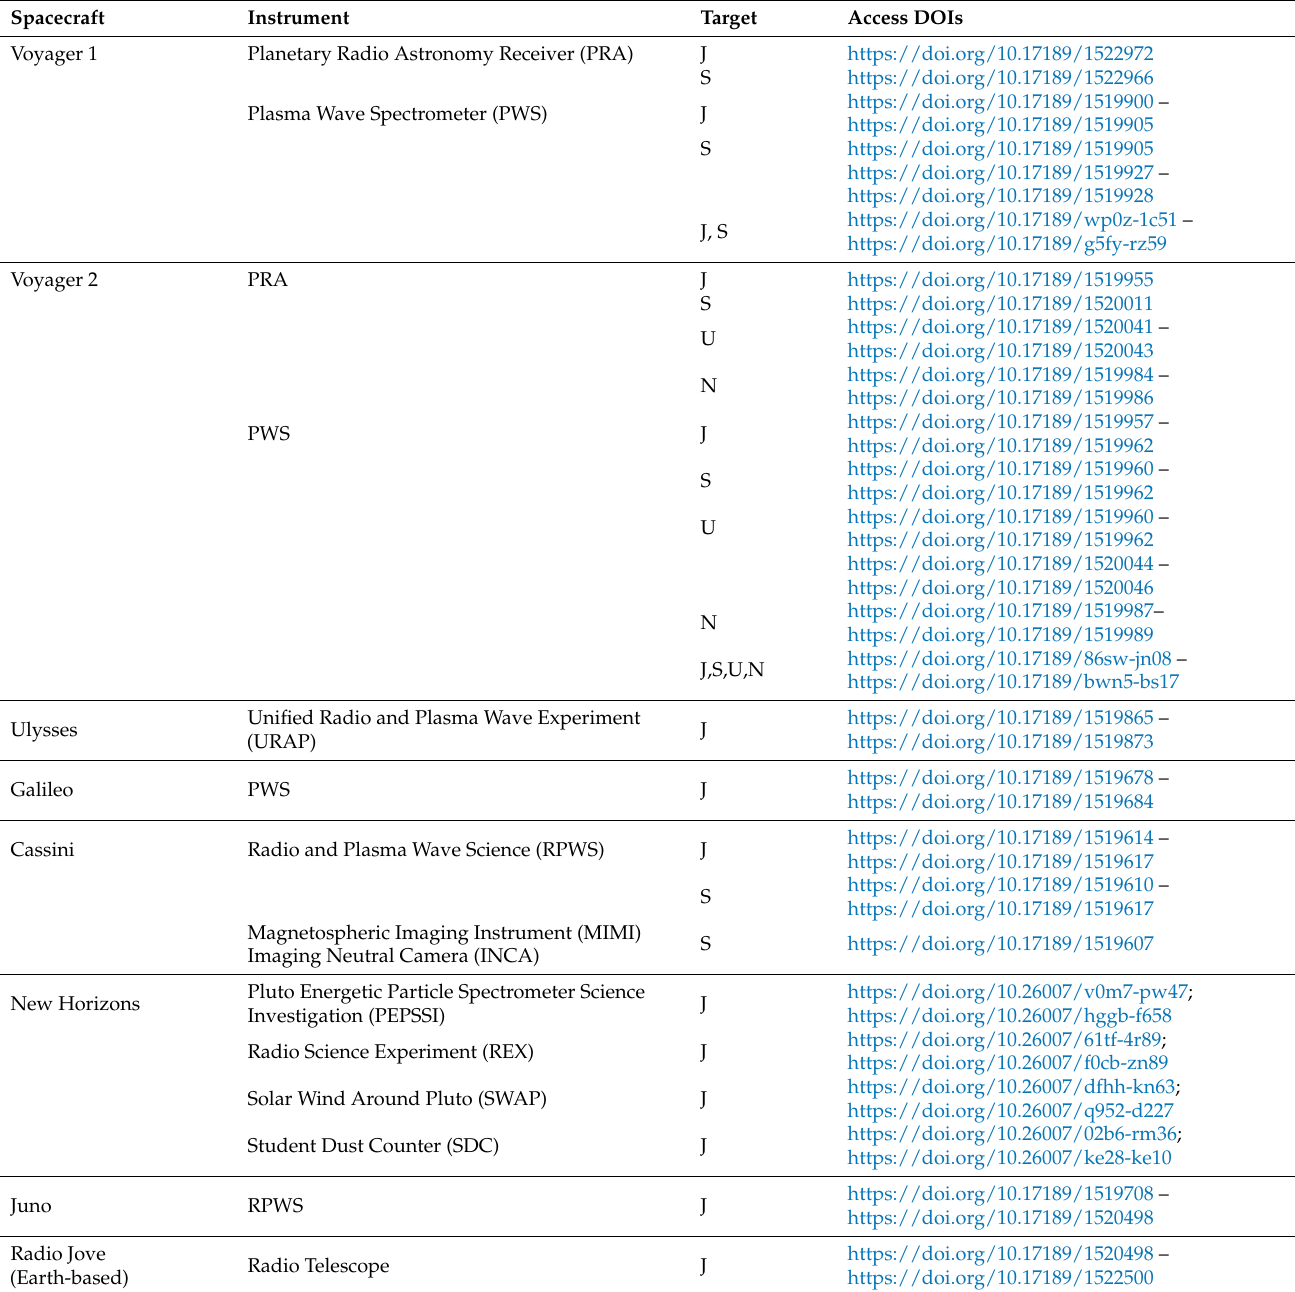
Table 3. Radio astronomy, plasma wave, and particle data for Jupiter (J), Saturn (S), Uranus (U) and Neptune (N) available in the PDS, and the DOIs for accessing the data. Several of the investigations listed have multiple data sets; in those cases, the range of sequential DOIs is given. All links in this table were accessed on 30 October